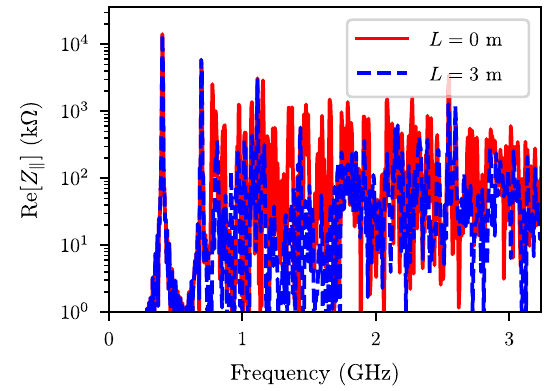
FIG. 10. Impedances of the full structure of four single-cell cavities with step ( L ¼ 0 ) and taper transitions (see Fig. 9).